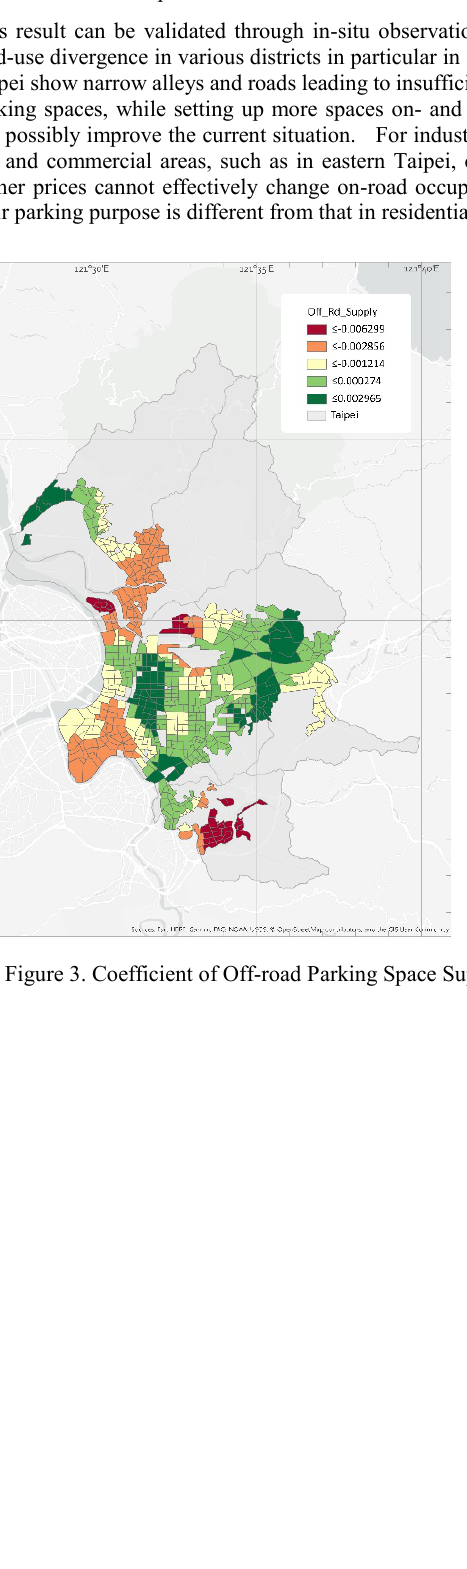
Table 6. Comparison of Global Model and GWR